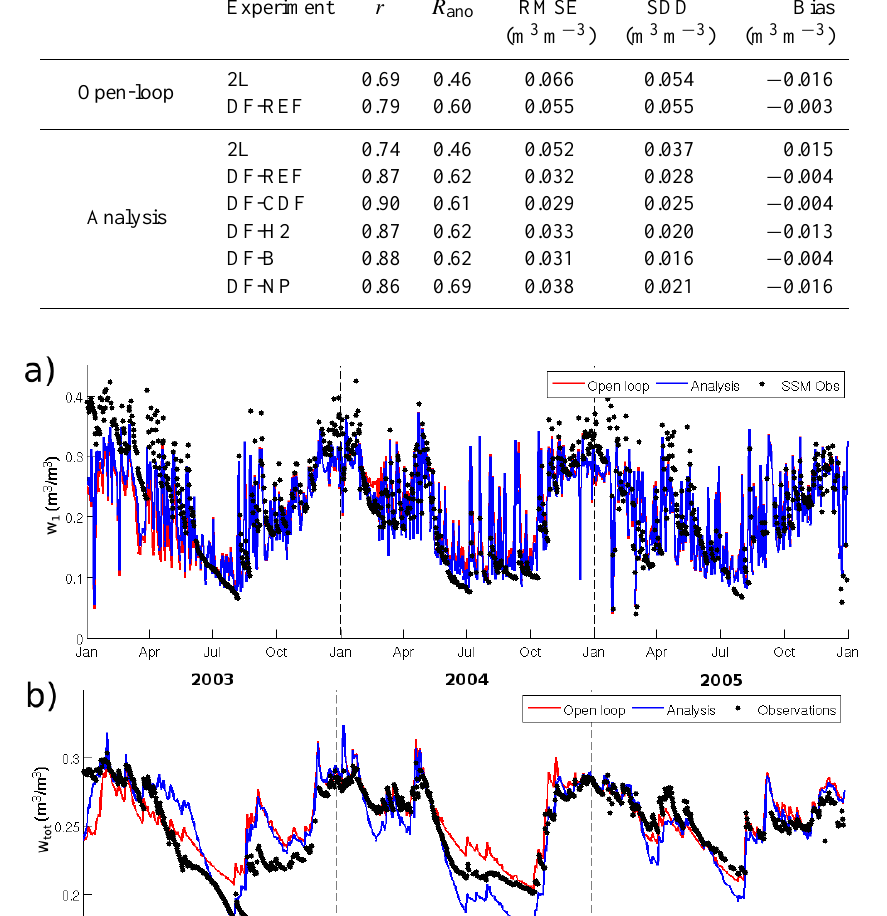
Table 2. w 1 open-loop and analysis scores ( r , RMSE, SDD and bias) computed over the 3yr period. Statistical scores are performed with rescaled observations.